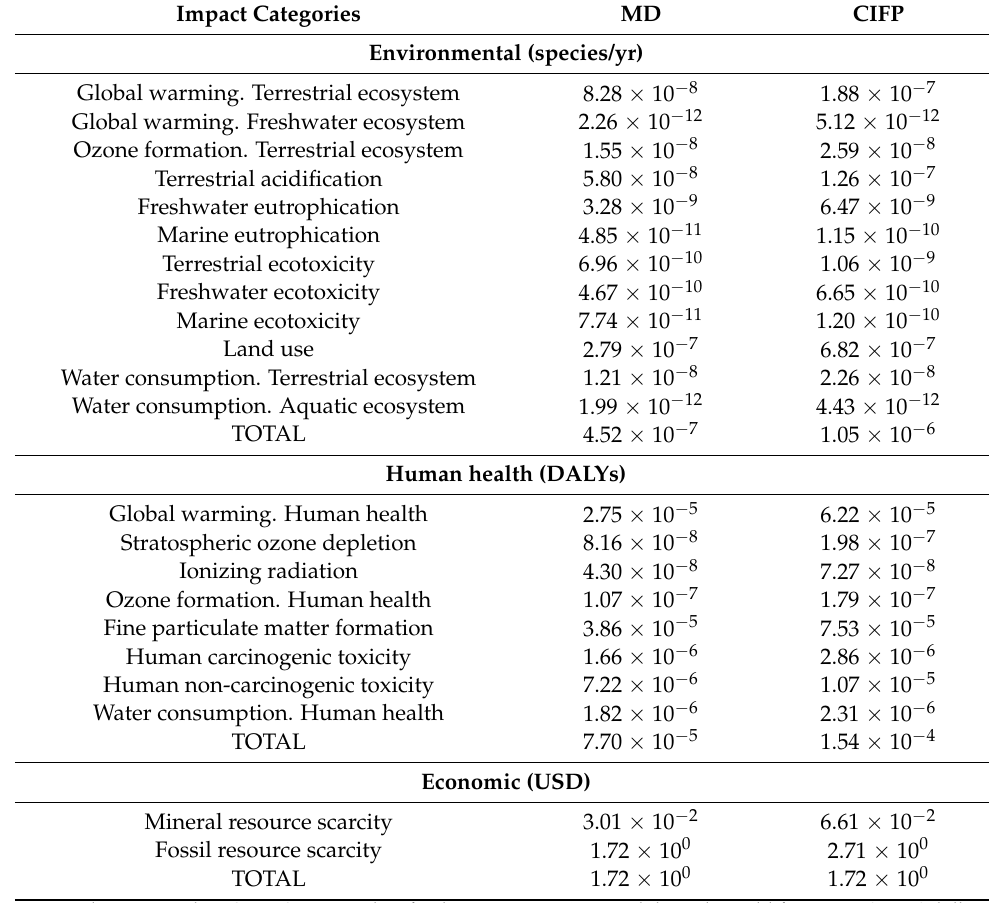
Table 2. Life cycle impact assessment results of ReCiPe 2016 Endpoint